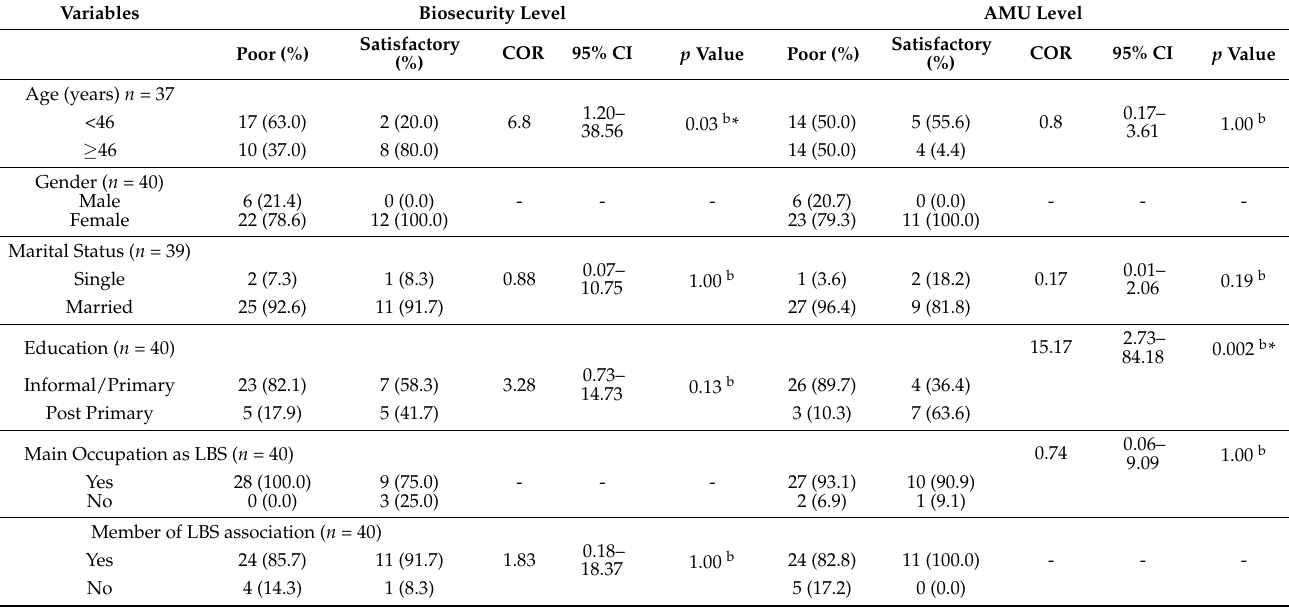
Table 3. Sociodemographic information of LBS associated with biosecurity and AMU using bivari- ate